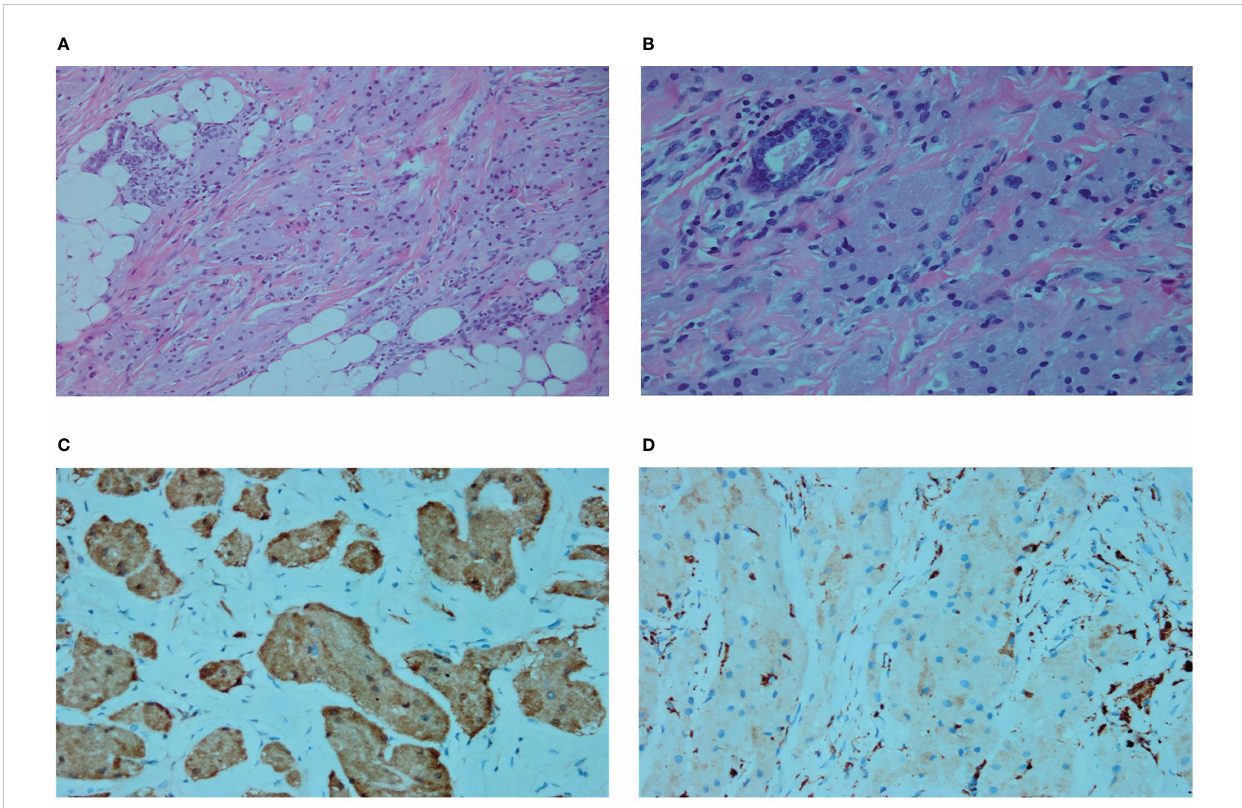
FIGURE 4 (A) Microscopic subcutaneous growth of in fi ltrative platelet-like growths of granulosa cells and vacuolated adipocytes are shown (Hematoxylin and eosin [H&E] staining, ×200). (B) In the fi brous septa, nest-like unencapsulated granulosa cells are also seen (H&E staining, ×400). (C) S100 cytoplasm showing diffuse and strong positivity (immunostaining, ×400). (D) CD68 weak positivity (immunostaining,